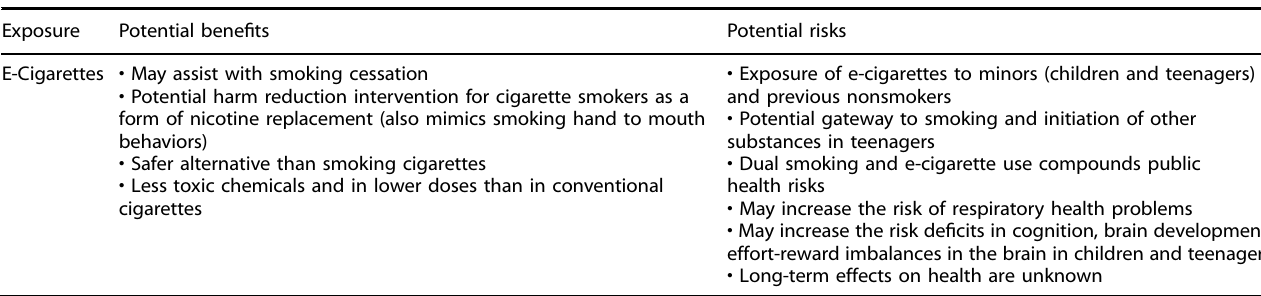
Table 3. E-Cigarettes Potential Harms and Bene fi ts 6,7,35,37,46 – 48,51,62,63,72 . Exposure Potential